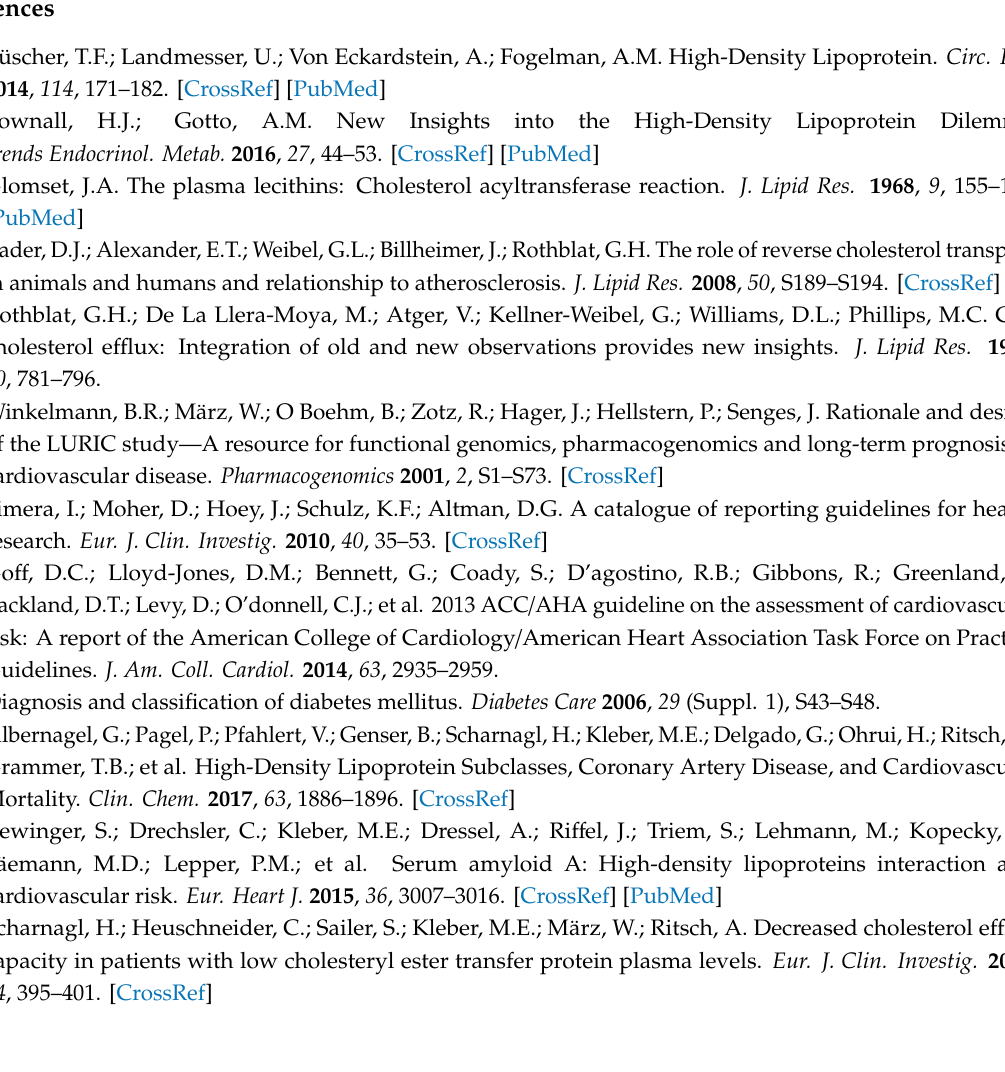
Figure S1: Association of absolute and relative HDL particle concentration with cholesterol e ffl ux; Figure S2: Spline curves showing hazard ratios for cardiovascular death according to cholesterol e ffl ux capacity in the whole study population ( n = 2468); Figure S3: Spline curves showing hazard ratios for cardiovascular death according to cholesterol e ffl ux capacity in CAD patients ( n = 1886); Figure S4: Box plots showing the distribution of cholesterol e ffl ux capacity according to cardiovascular risk factors; Figure S5: Box plots showing the distribution of cholesterol e ffl ux capacity according to HDL parameters; Table S1. Hazard ratio for cardiovascular death according to cholesterol e ffl ux in 833 patients of the LURIC study without a history of an acute coronary event but with a high risk for CAD (pooled cohort equation >